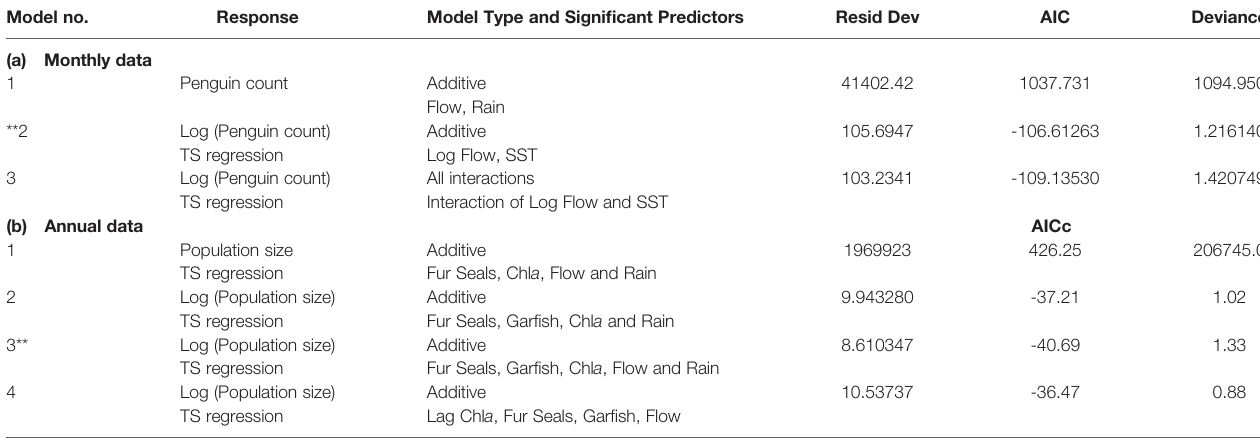
TABLE 2 | Best models explaining little penguin numbers on Granite Island. Data are presented for (a) the monthly dataset and (b) the annual dataset. Model no.